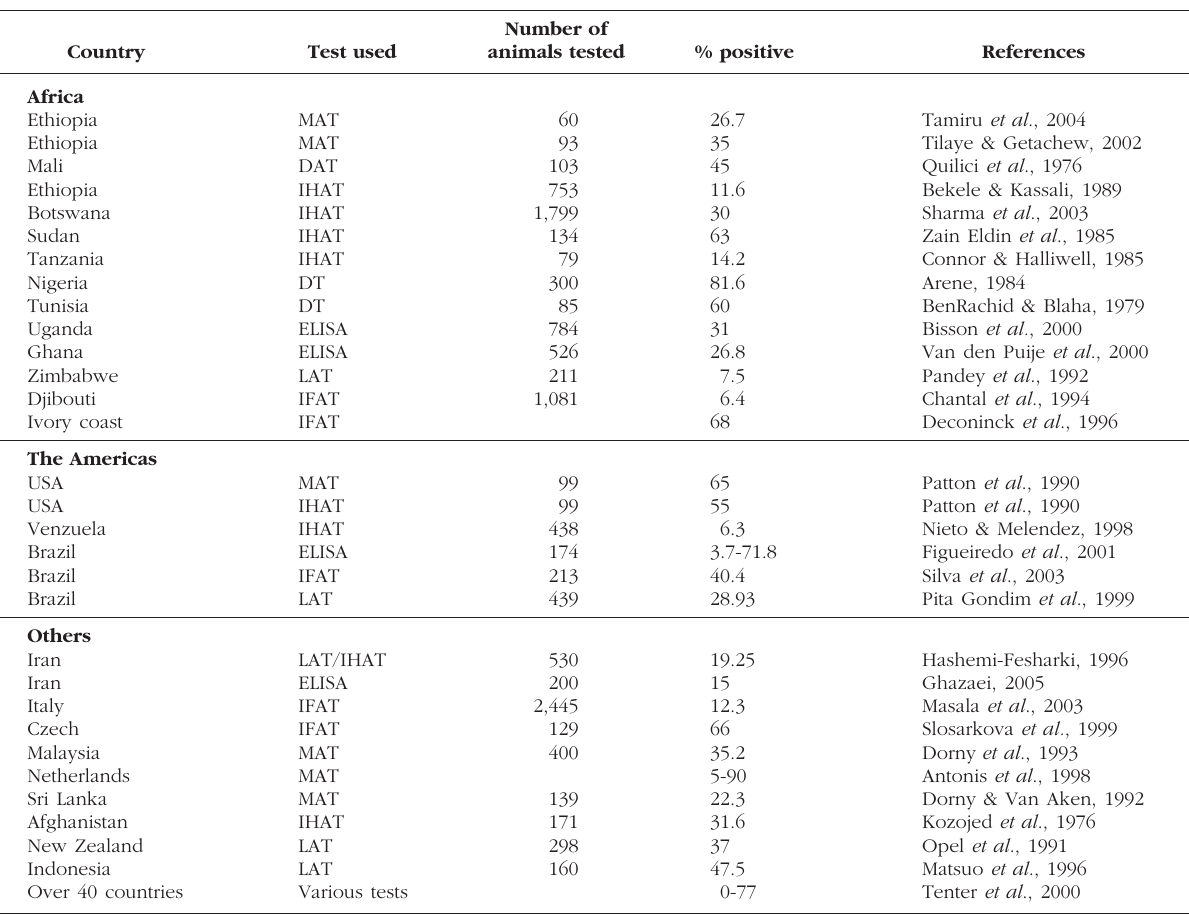
Table II. – Seroprevalence of T. gondii infections in goats from previous